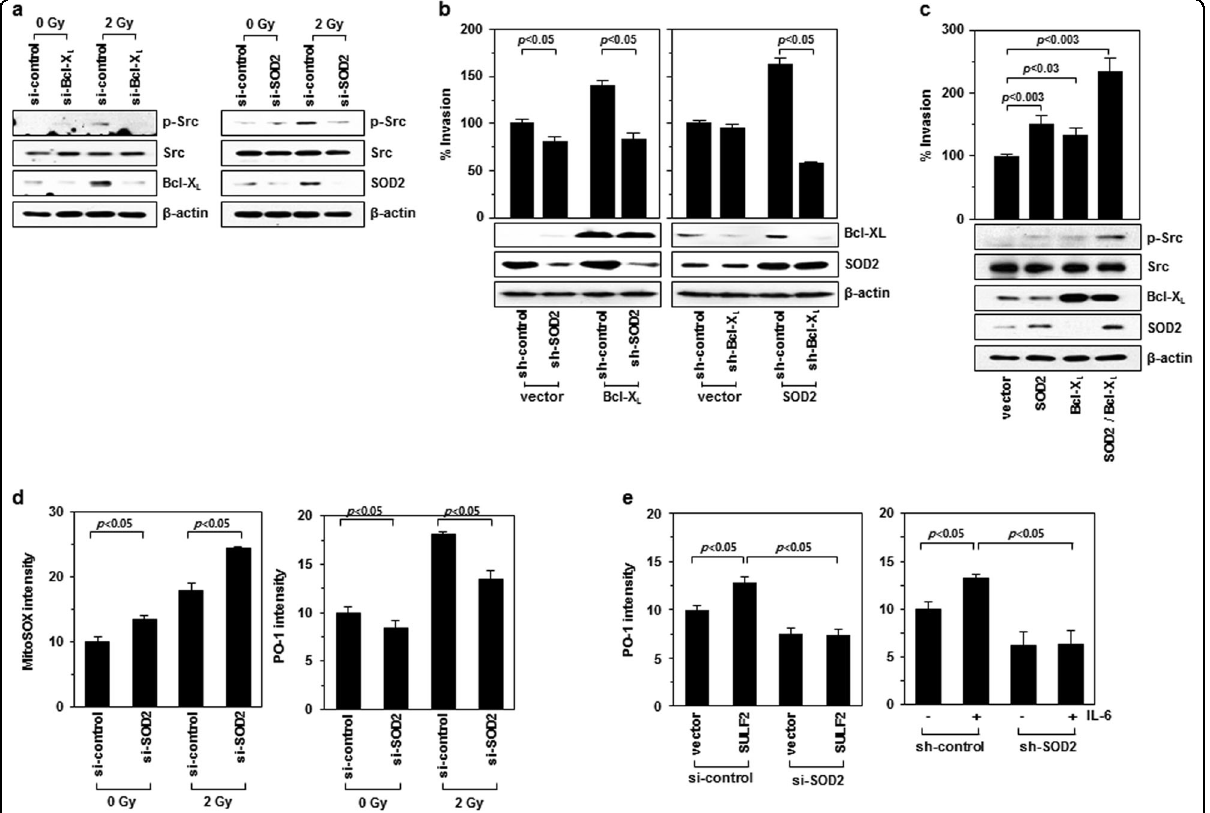
Fig. 4 Bcl-XL and SOD2 functionally cooperate to promote Src phosphorylation and cell invasion. a H460 cells treated with a control, Bcl-X L - targeting, or SOD2-targeting siRNA were irradiated, and the levels of the indicated proteins were compared 24 h after irradiation. b H460 cells infected with lentiviruses expressing the speci fi ed shRNAs were transfected with a Bcl-X L or SOD2 expression vector in the indicated combinations. Cellular invasiveness and the levels of Bcl-X L and SOD2 were compared after 48 h of incubation. c H460 cells were transfected with a Bcl-X L or SOD2 expression vector in the indicated combinations. Cellular invasiveness and the levels of the indicated proteins were compared after 48 h of incubation. d H460 cells treated with a control or SOD2-targeting siRNA were irradiated (2 Gy). After 48 h of incubation, irradiated and untreated control cells were analyzed for their levels of O 2 (cid:129) − and H 2 O 2 using MitoSox Red and Peroxy Orange-1, respectively. e H460 cells were transfected with a SULF2 expression vector and SOD2-targeting siRNA in the indicated combinations (left). Alternatively, H460 cells infected with lentiviruses expressing a control or SOD2-targeting shRNA were incubated in the presence or absence of 100 ng/mL IL-6 (right). After treatment for 24 h, cellular H 2 O 2 levels were compared using Peroxy